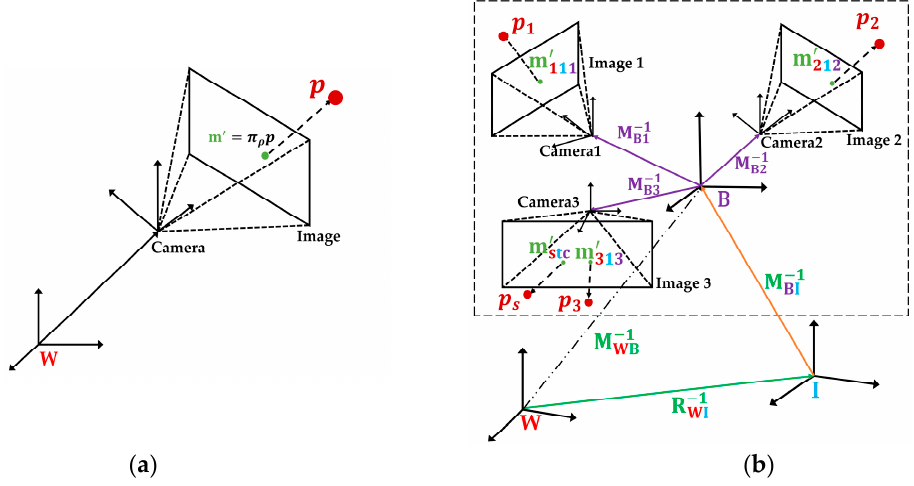
Figure 2. Different camera models. ( a ) Camera model for a single camera; ( b ) The proposed Multicol-IMU camera model. Compared to the single camera model in Figure 2a, the proposed MultiCol-IMU camera model in Figure 2b had two intermediate frames: A body frame B and an IMU frame I .